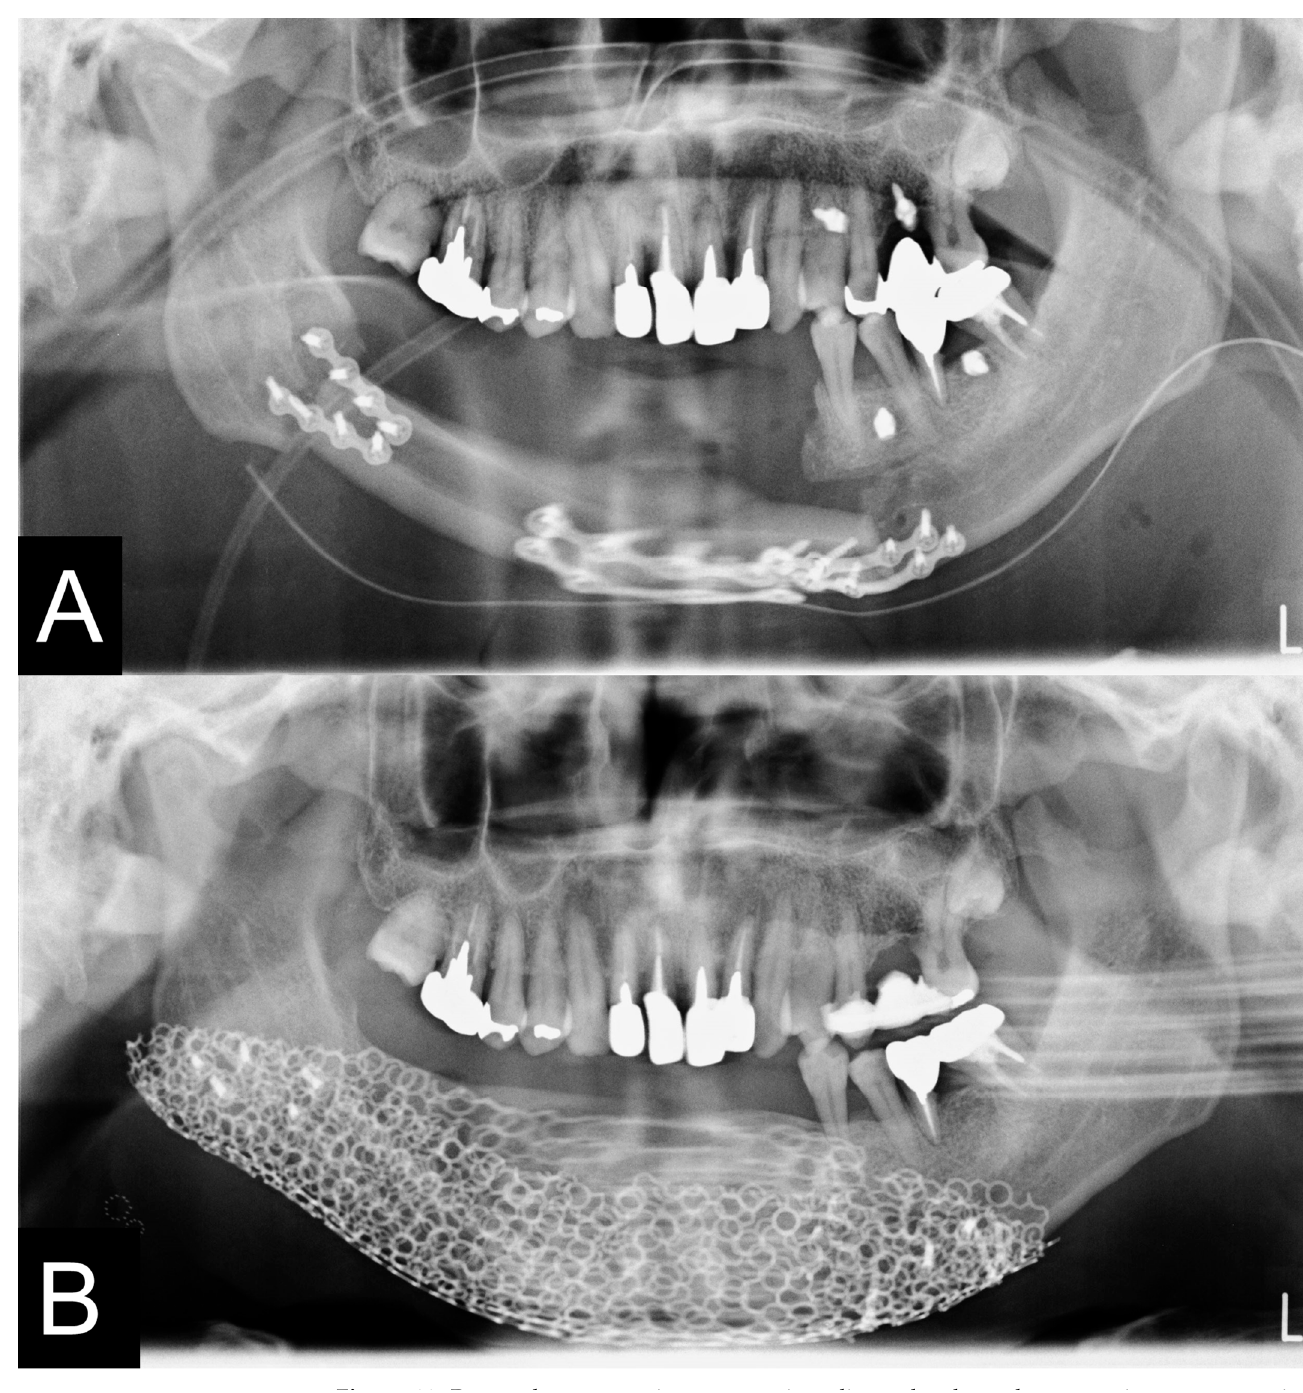
Figure 11. Pre- and postoperative panoramic radiographs showed accurate jaw reconstruction. ( A , B ). The deviated mandible was cut at the junction of the fibula and mandible with a cutting de- vice. The patient’s pre-bended custom-made TiMesh was fixed with a positioning device and a PCBM was grafted. After the operation, the optimum alveolar crest was reconstructed for the dental implant placement and the positions of condyles were improved.